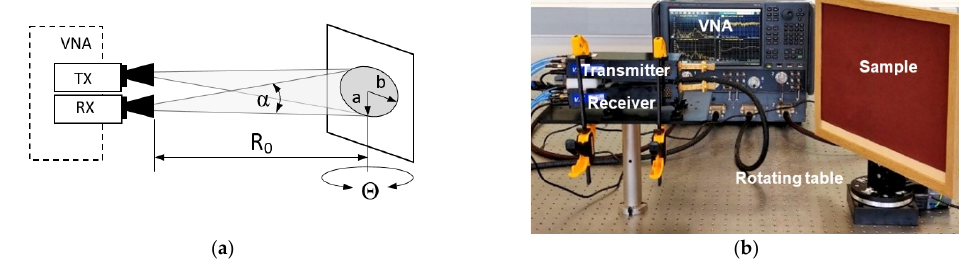
Table 2. Parameters of the measurement system.